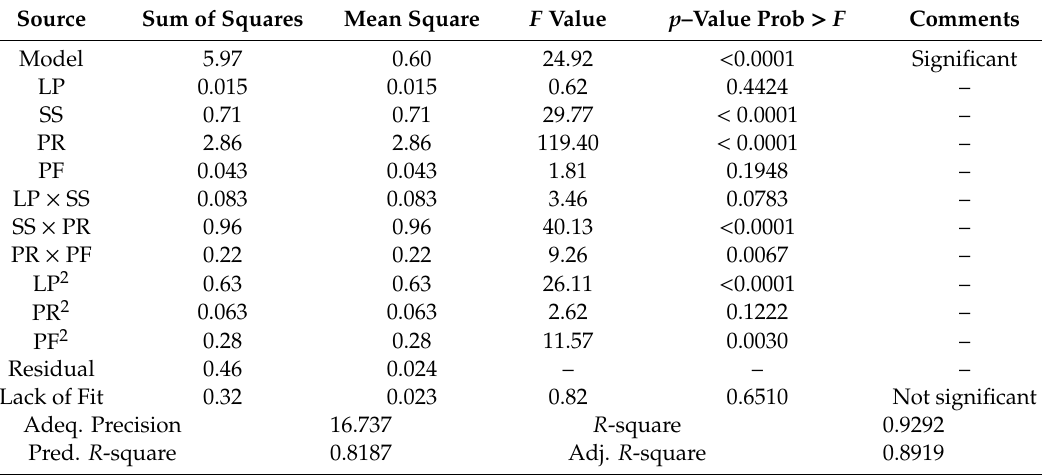
Table 6. Analysis of variance on defect